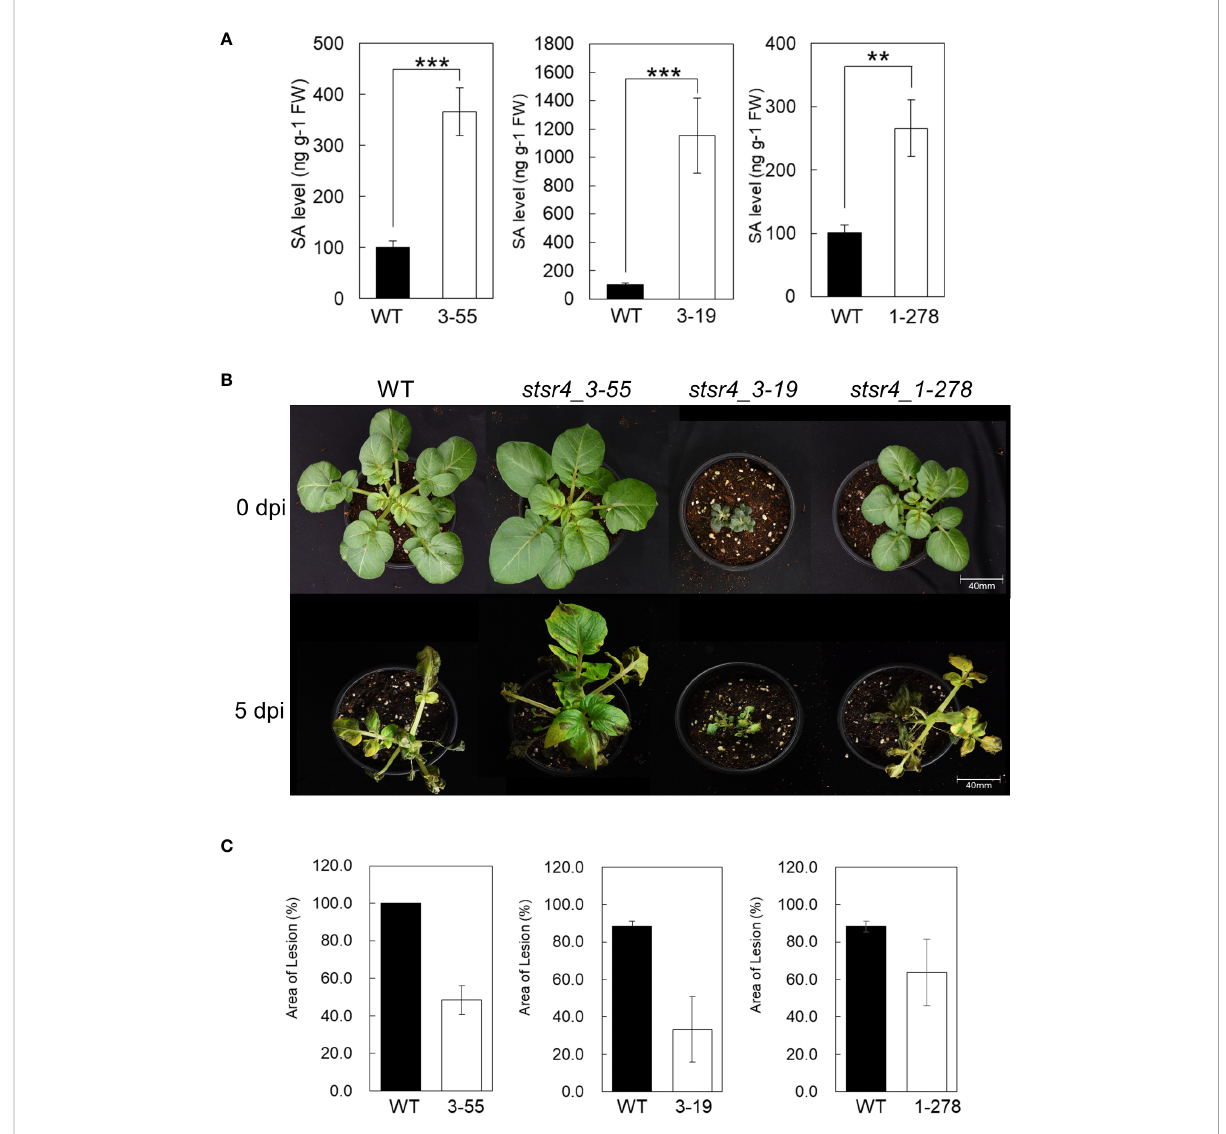
FIGURE 5 Plant immune response through the suppression of StSR4 expression is regulated by SA. (A) Quanti fi cation of free SA in three stsr4 mutants ( stsr4_3-55, stsr4_3-19 , and stsr4_1-278 ). Data represent the mean±SE of fi ve biological replicates. Asterisks indicate signi fi cant differences (Student ’ s t -test; **p<0.01, *** p <0.001). (B) Growth at 25°C for 3 weeks in pots of three mutants before pathogen resistance experiment. (C) Disease symptoms observed on the leaves of wild type and stsr4_3-55 and stsr4_3-19 mutant plants at 0 days post-inoculation (dpi) and